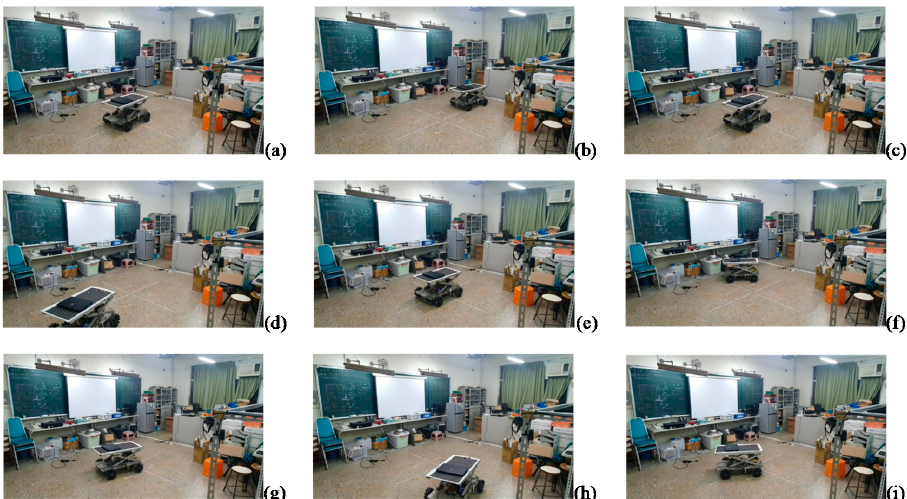
Figure 21. The captured pictures of the robot’s cross-walking motion without RLS estimation and compensation. ( a ) Starting position, ( b ) forward, ( c ) back to the starting position, ( d ) backward, ( e ) back to the starting position, ( f ) left shift, ( g ) back to the starting position, ( h ) right shift, ( i ) back to the starting position.